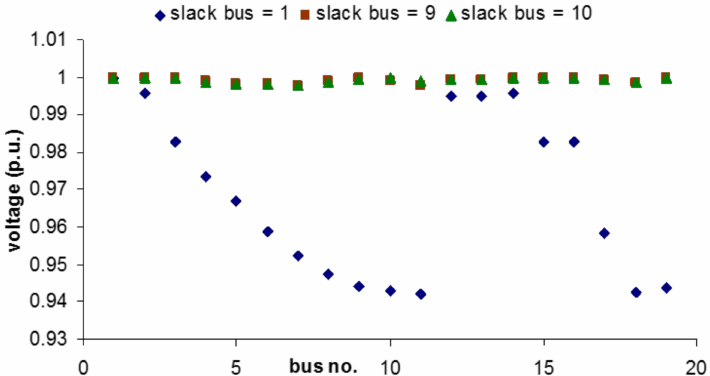
Figure 21. Voltage profile for different locations of PV system in the Rajmachi